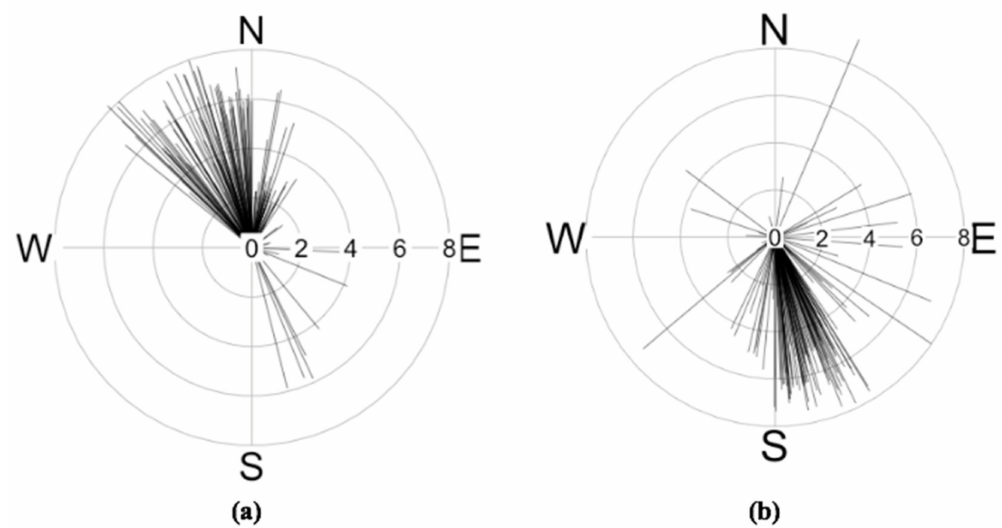
Figure 7. Wind distribution stick plots. Each “stick” represents the average wind direction and speed (in meters per second) during one hour of the indicated week (168 hours); 65% of all sticks fell in the NW sector ( a ), while only 5% fell in the NW sector ( b ).